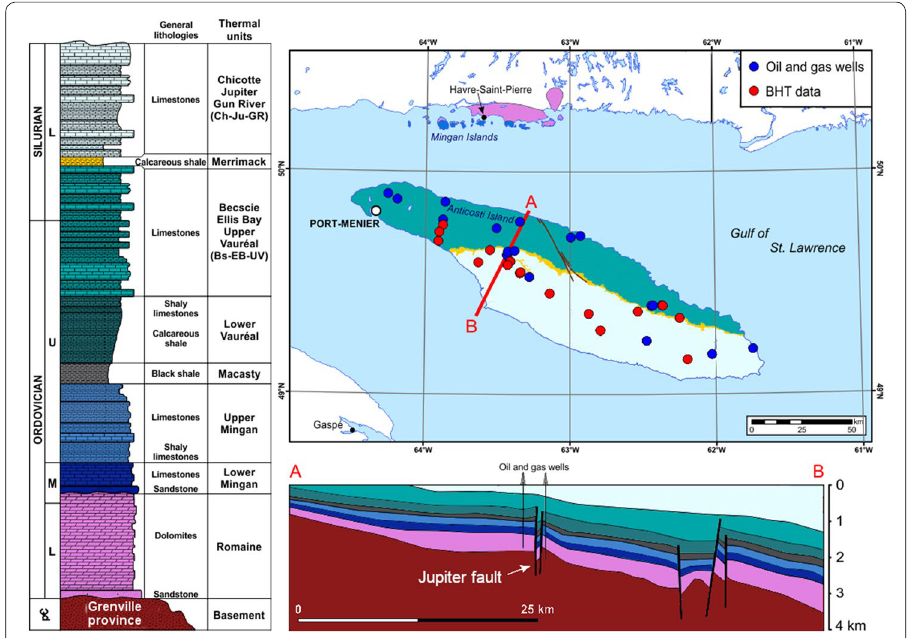
Fig. 2 General architecture of the Anticosti sedimentary basin and location of the well data used in this study (adapted from Castonguay et al. (2005) and Bédard et al.